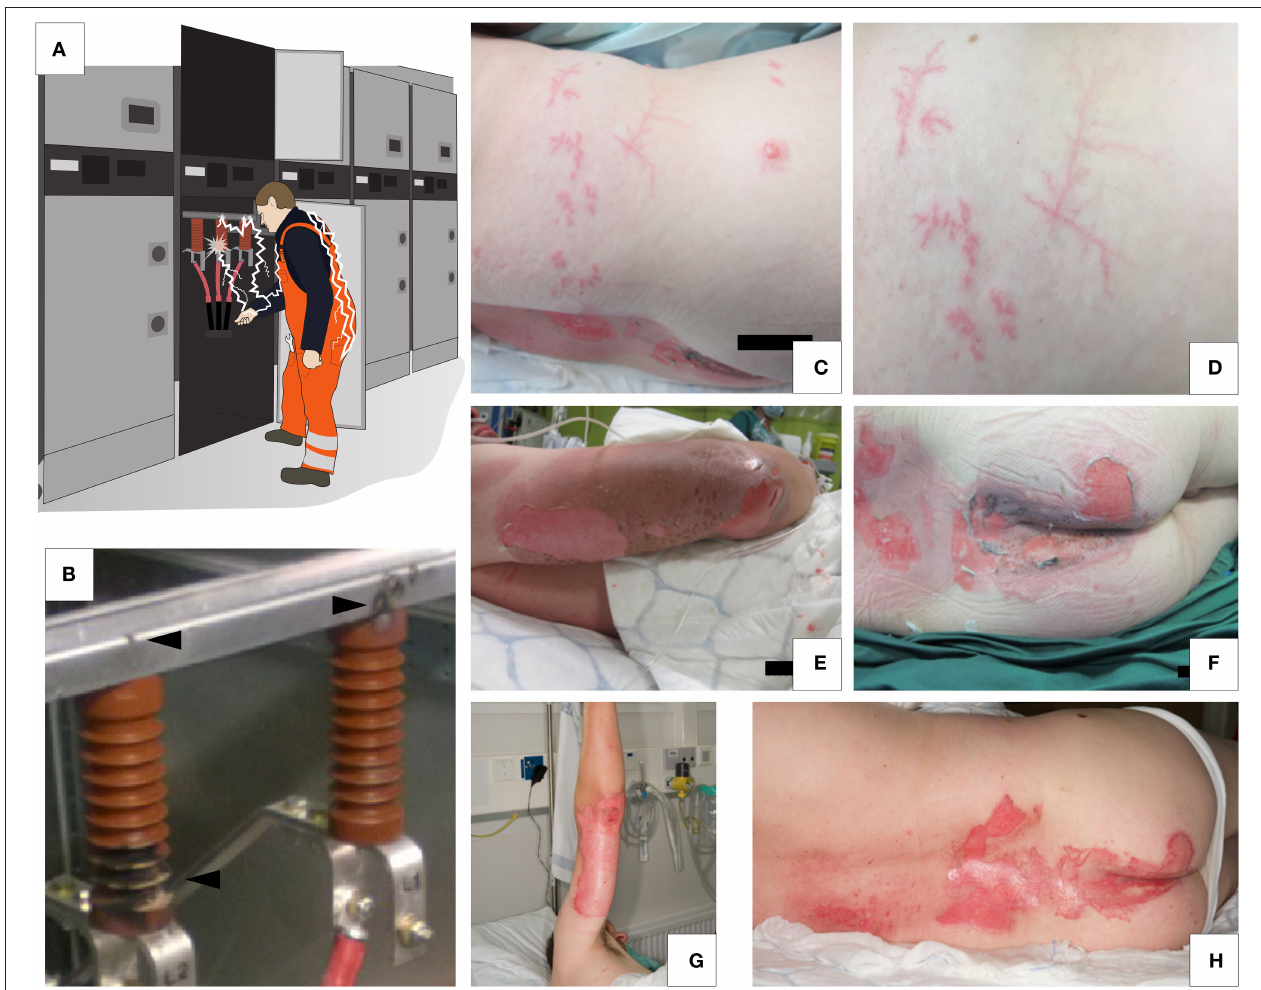
FIGURE 1 | (A) Mechanism of the electric arc injury from the 20 kV medium-voltage switchgear at inspection. (B) Light-arc and electric discharge-induced damage marks in the switchgear. (C,D) Lichtenberg figures on the right flank. (E,F) Second-degree dermal burns involving right arm, lower back and buttocks. (G,H) Burn wounds on right arm, lower back and buttocks after 3 days. Lichtenberg figures not